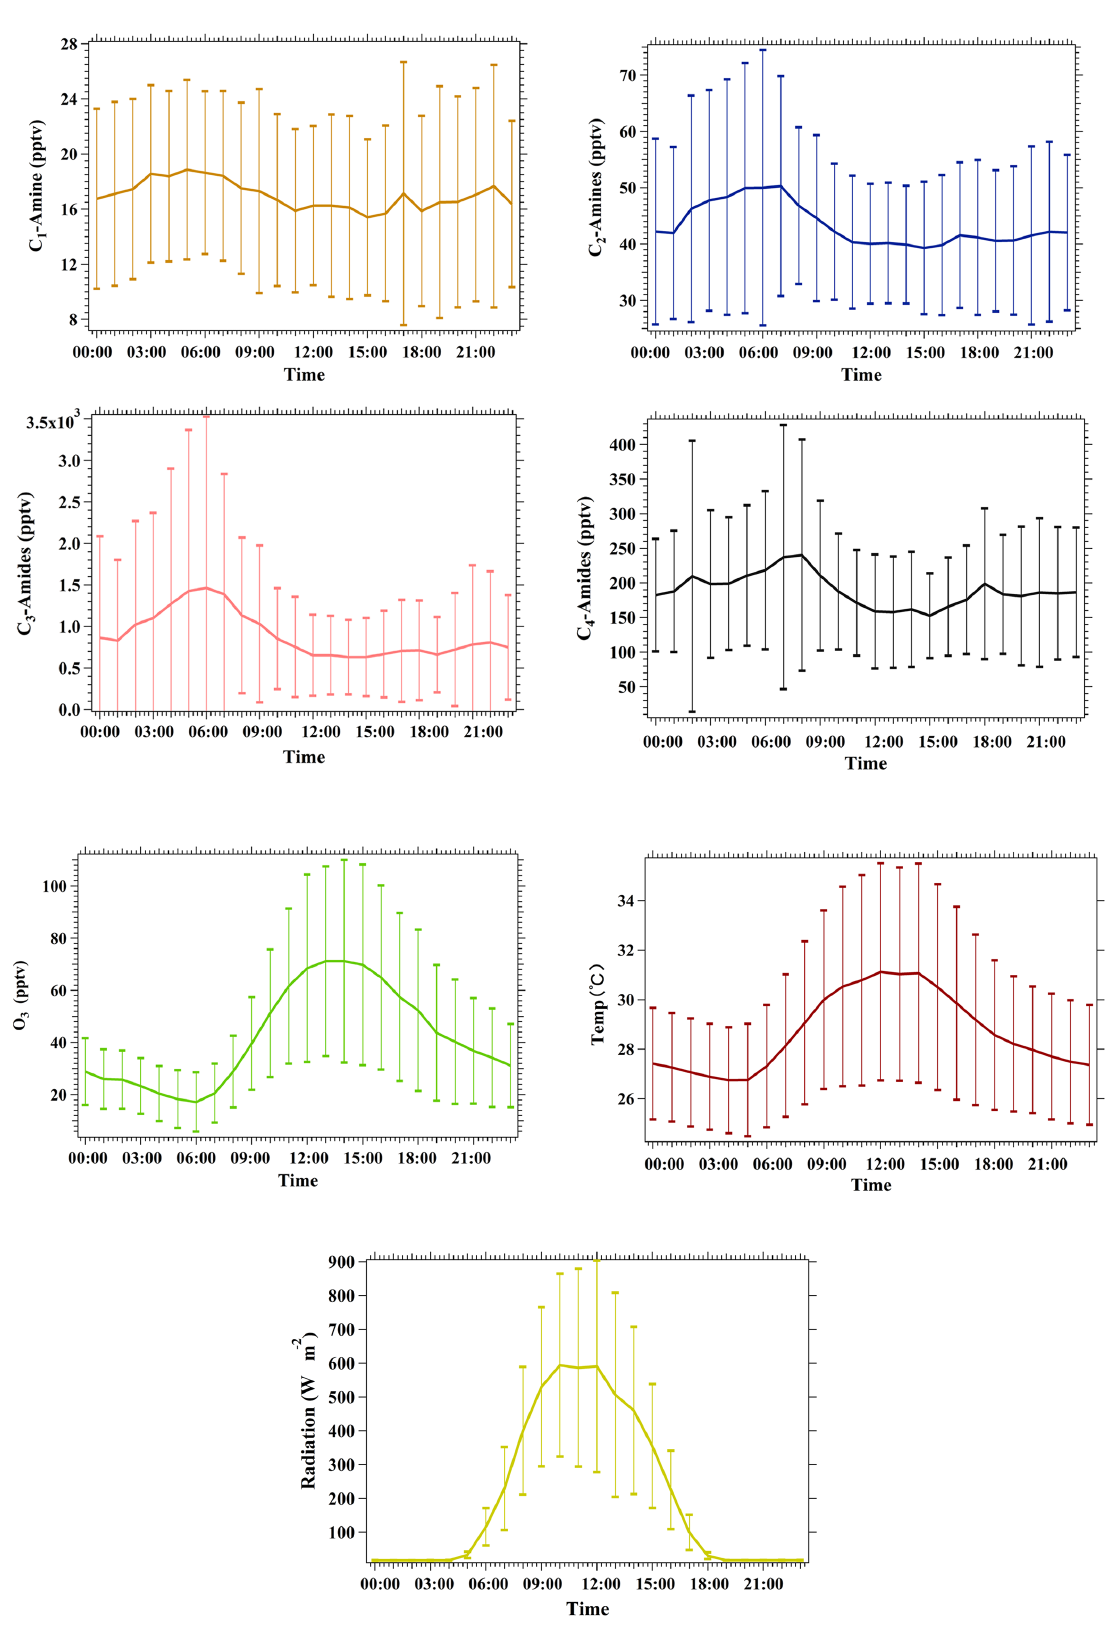
Figure 7. The averaged diurnal profiles of C 1 - and C 2 -amines and C 3 - and C 4 -amides, together with those of temperature, radiation, and ozone concentration during the